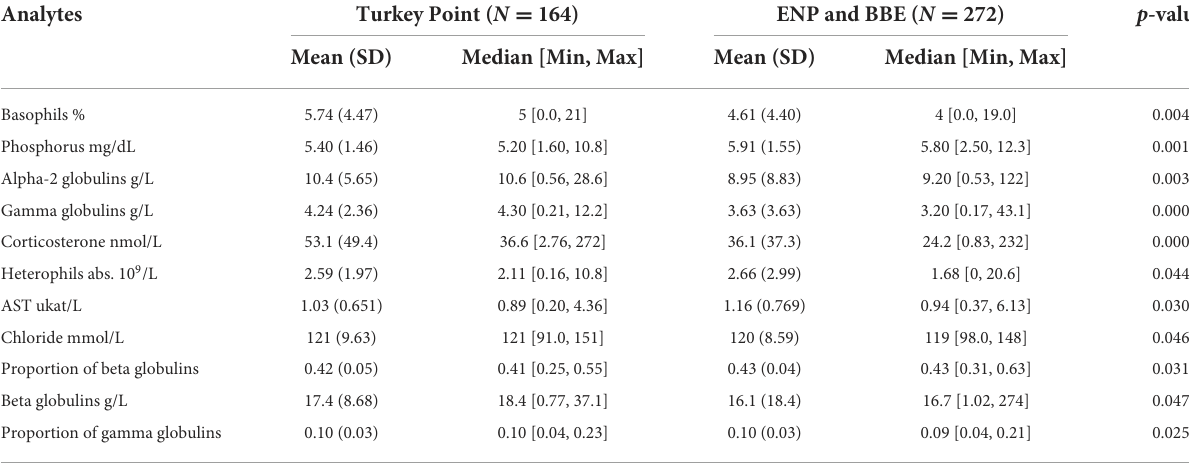
TABLE 1 General statistics of American crocodile ( Crocodylus acutus ) hematological and biochemical analytes with very strong-to-moderate evidence of being affected by areas (high human influenced—Turkey Point Nuclear Power Plant vs. low-to-medium human influenced—Everglades National Park—ENP and Biscayne Bay Estuary—BBE) in South Florida, United States, based on an equal means test (Wilcoxon’s sum rank test).